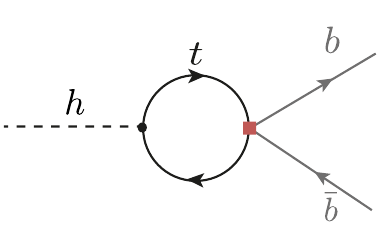
Figure 2 . Feynman diagram contributing to the NLO h → bb